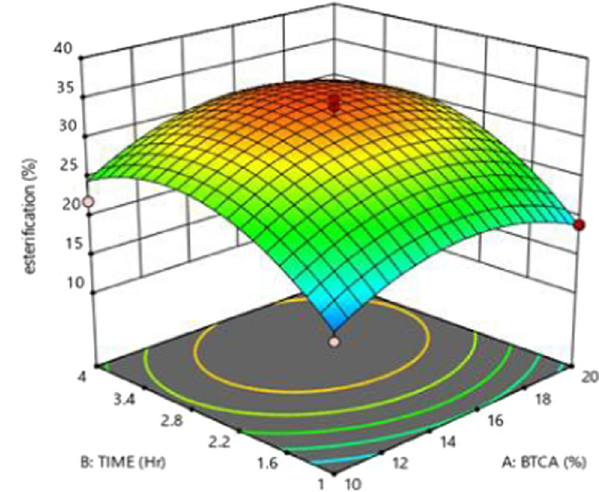
Fig. 4 Effect of BTCA concen- tration and time on